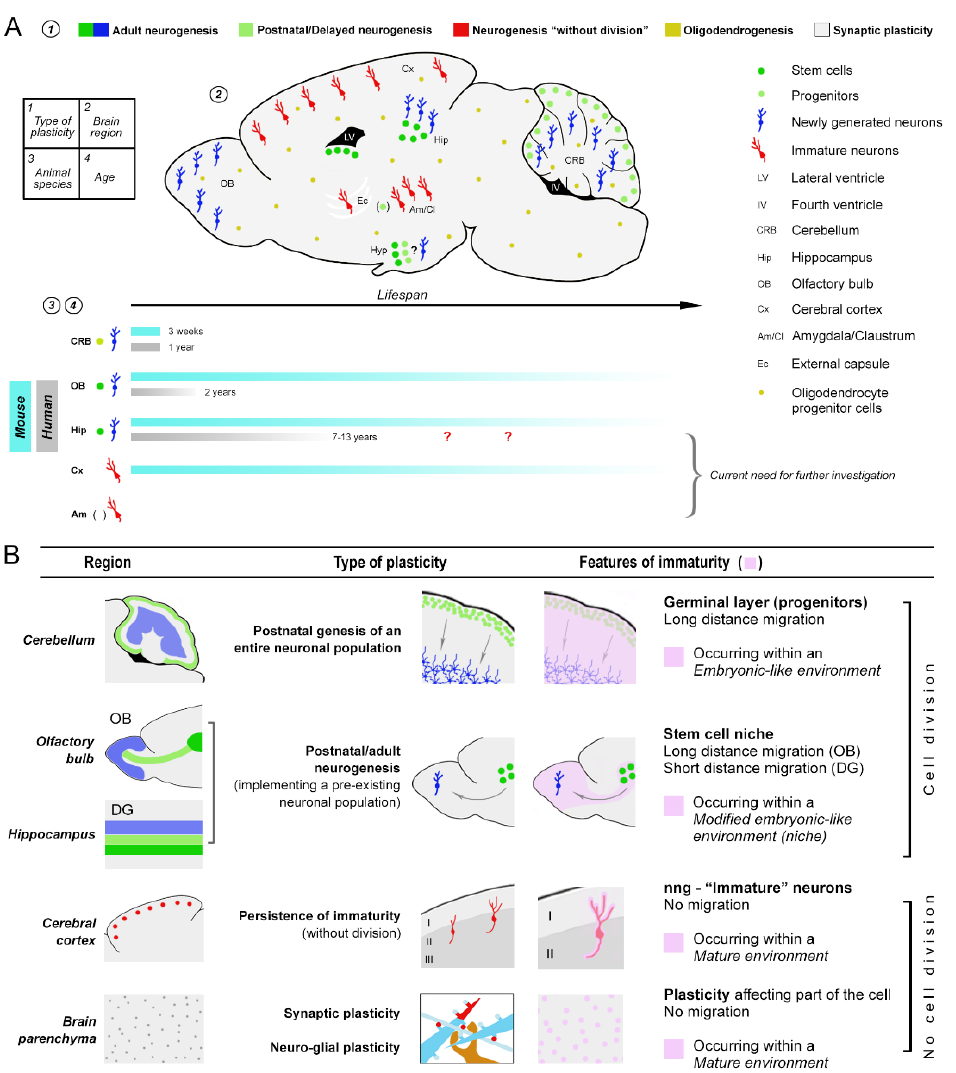
Figure 2. Immaturity persisting prior to the full maturation of the nervous tissue can grant plasticity, yet the processes involved occur differently depending on four main variables. Plasticity varies by species, brain region, and age. ( A ) Sagittal view of the mouse brain is used to represent mammalian brain regions (e.g., the immature neurons are not present in the mouse neocortex but they can be found in many large-brained species; see text) and to summarize the extreme heterogeneity of plasticity/immaturity in mammals. Due to a lack of comparative (and comparable) quantitative studies across widely different species, the current knowledge is far from being complete and merits further investigation in large-brained mammals in order to integrate data obtained in laboratory rodents. ( B ) A brief survey of the main biological (plastic) processes involved in brain plasticity and maturation, adding detail to scheme (A), highlight the heterogeneity of variables to be taken into account by comparing animal